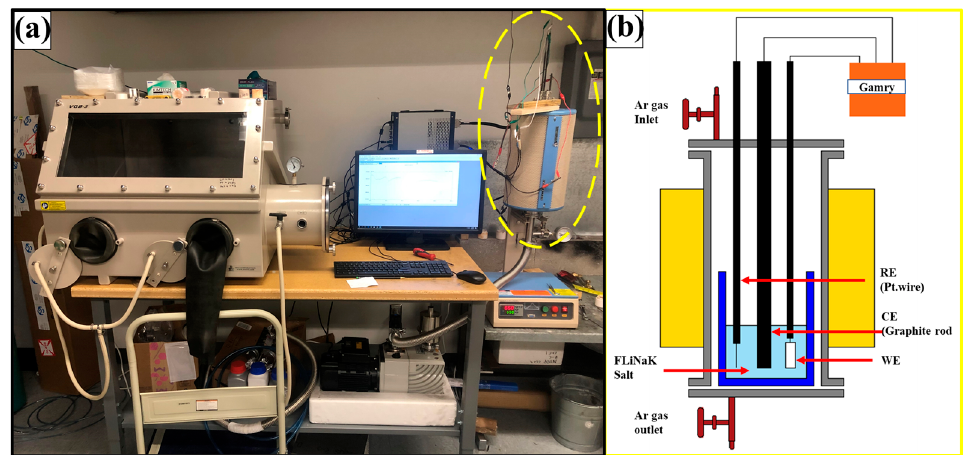
Figure 1. ( a ) Glove box and vertical tube furnace used as an electrochemical cell for molten-salt corrosion experiments; ( b ) schematic of the electrochemical cell with three electrodes for potentiodynamic polarization studies in molten FLiNaK salt.